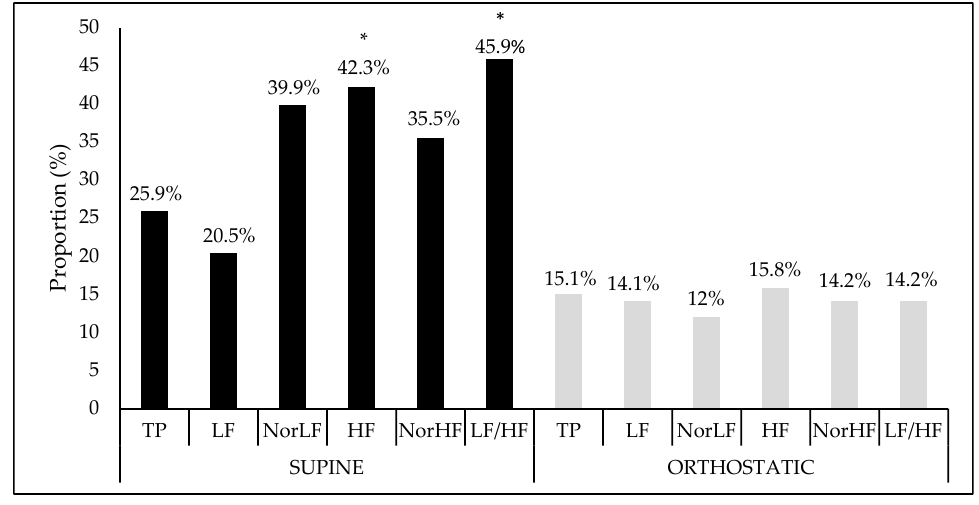
Figure 2. Interference proportion (%) of crude model adjusted to covariables in relation at the heart rate variability indices in the supine and orthostatic position. TP: Total power area; LF: Low frequency; NorLF: Normalized low frequency; HF: High frequency; NorHF: Normalized high frequency; LF / HF: Ratio low frequency / high frequency.* Significance at F <